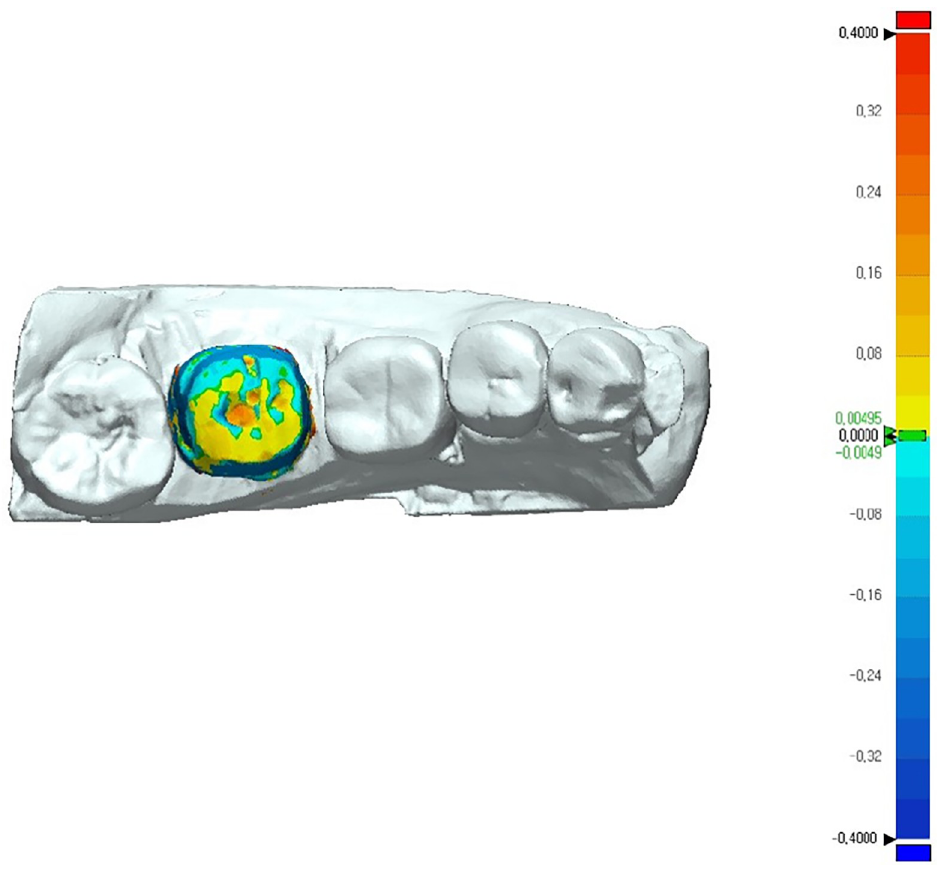
Fig 7. Three-dimensional deviations between the comparison and reference STL files using GeoMagic